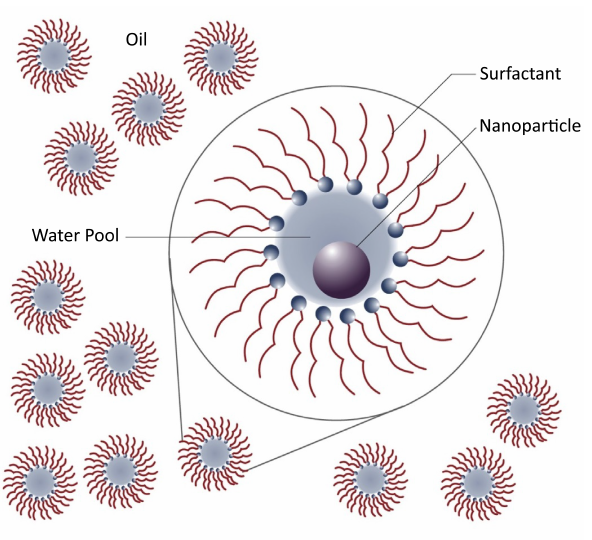
Figure 17. Scheme of a water-in-oil emulsion stabilized with surfactant and nanoparticles. Figure reproduced from Refs.